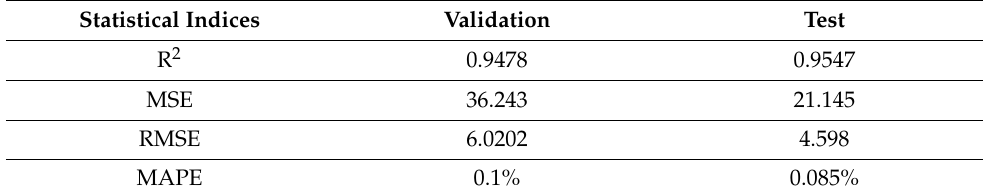
Table 3. Model’s efficiency and errors.